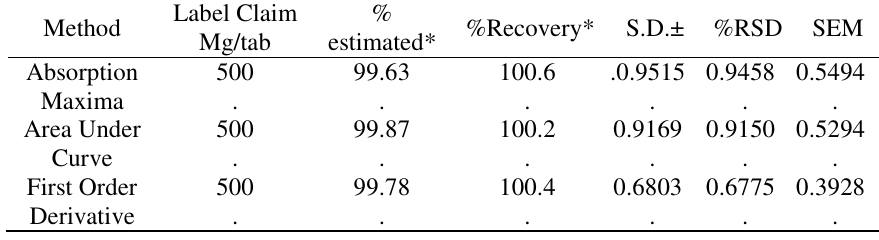
Table 2. Results of analysis of nabumetone in tablet formulation and recovery studies Method